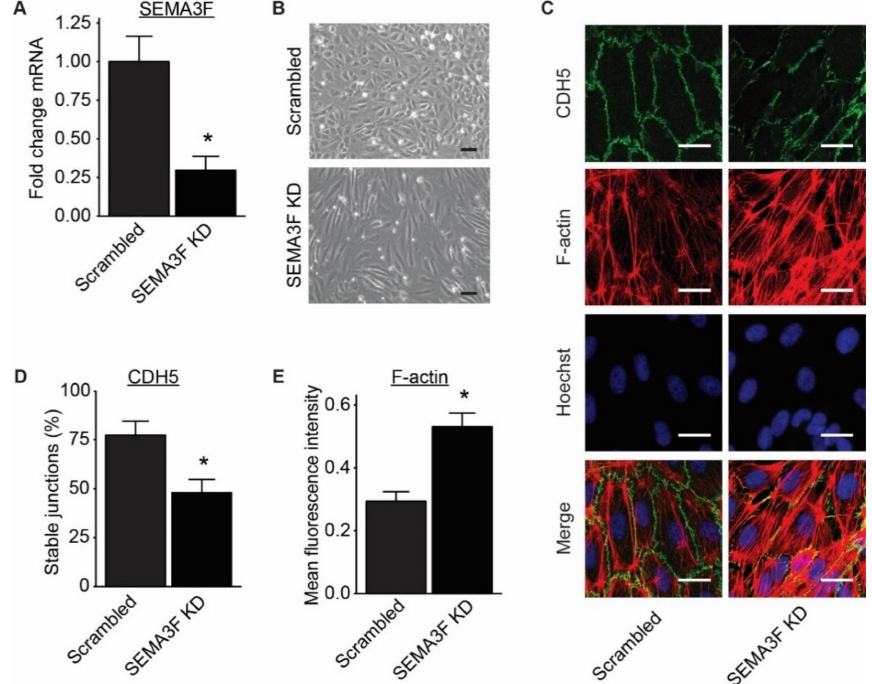
Figure 5. Reduction of SEMA3F expression in endothelial cells leads to disrupted endothelial adherens junctions. ( A ) SEMA3F mRNA expression after transduction with lentiviral anti-SEMA3F